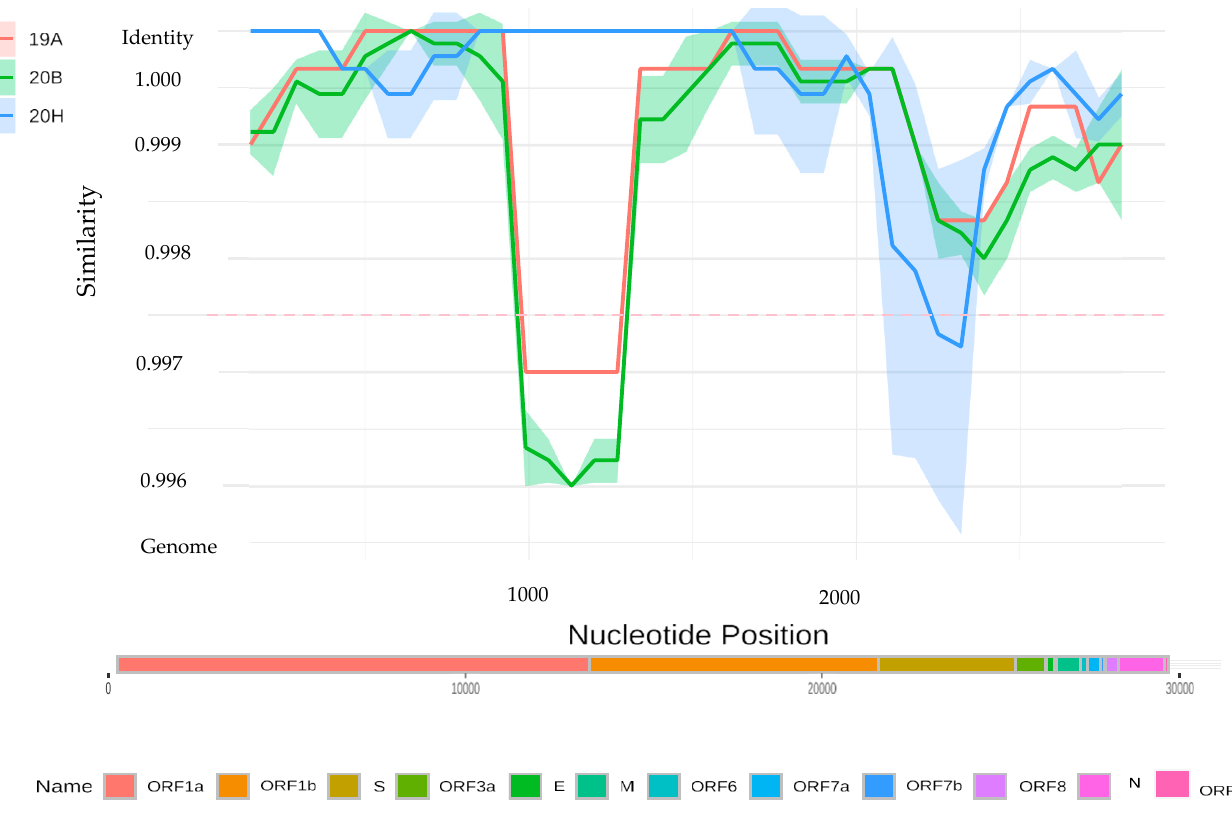
tree included eighty SARS-CoV-2 sequences from Congolese people and the reference sequences of